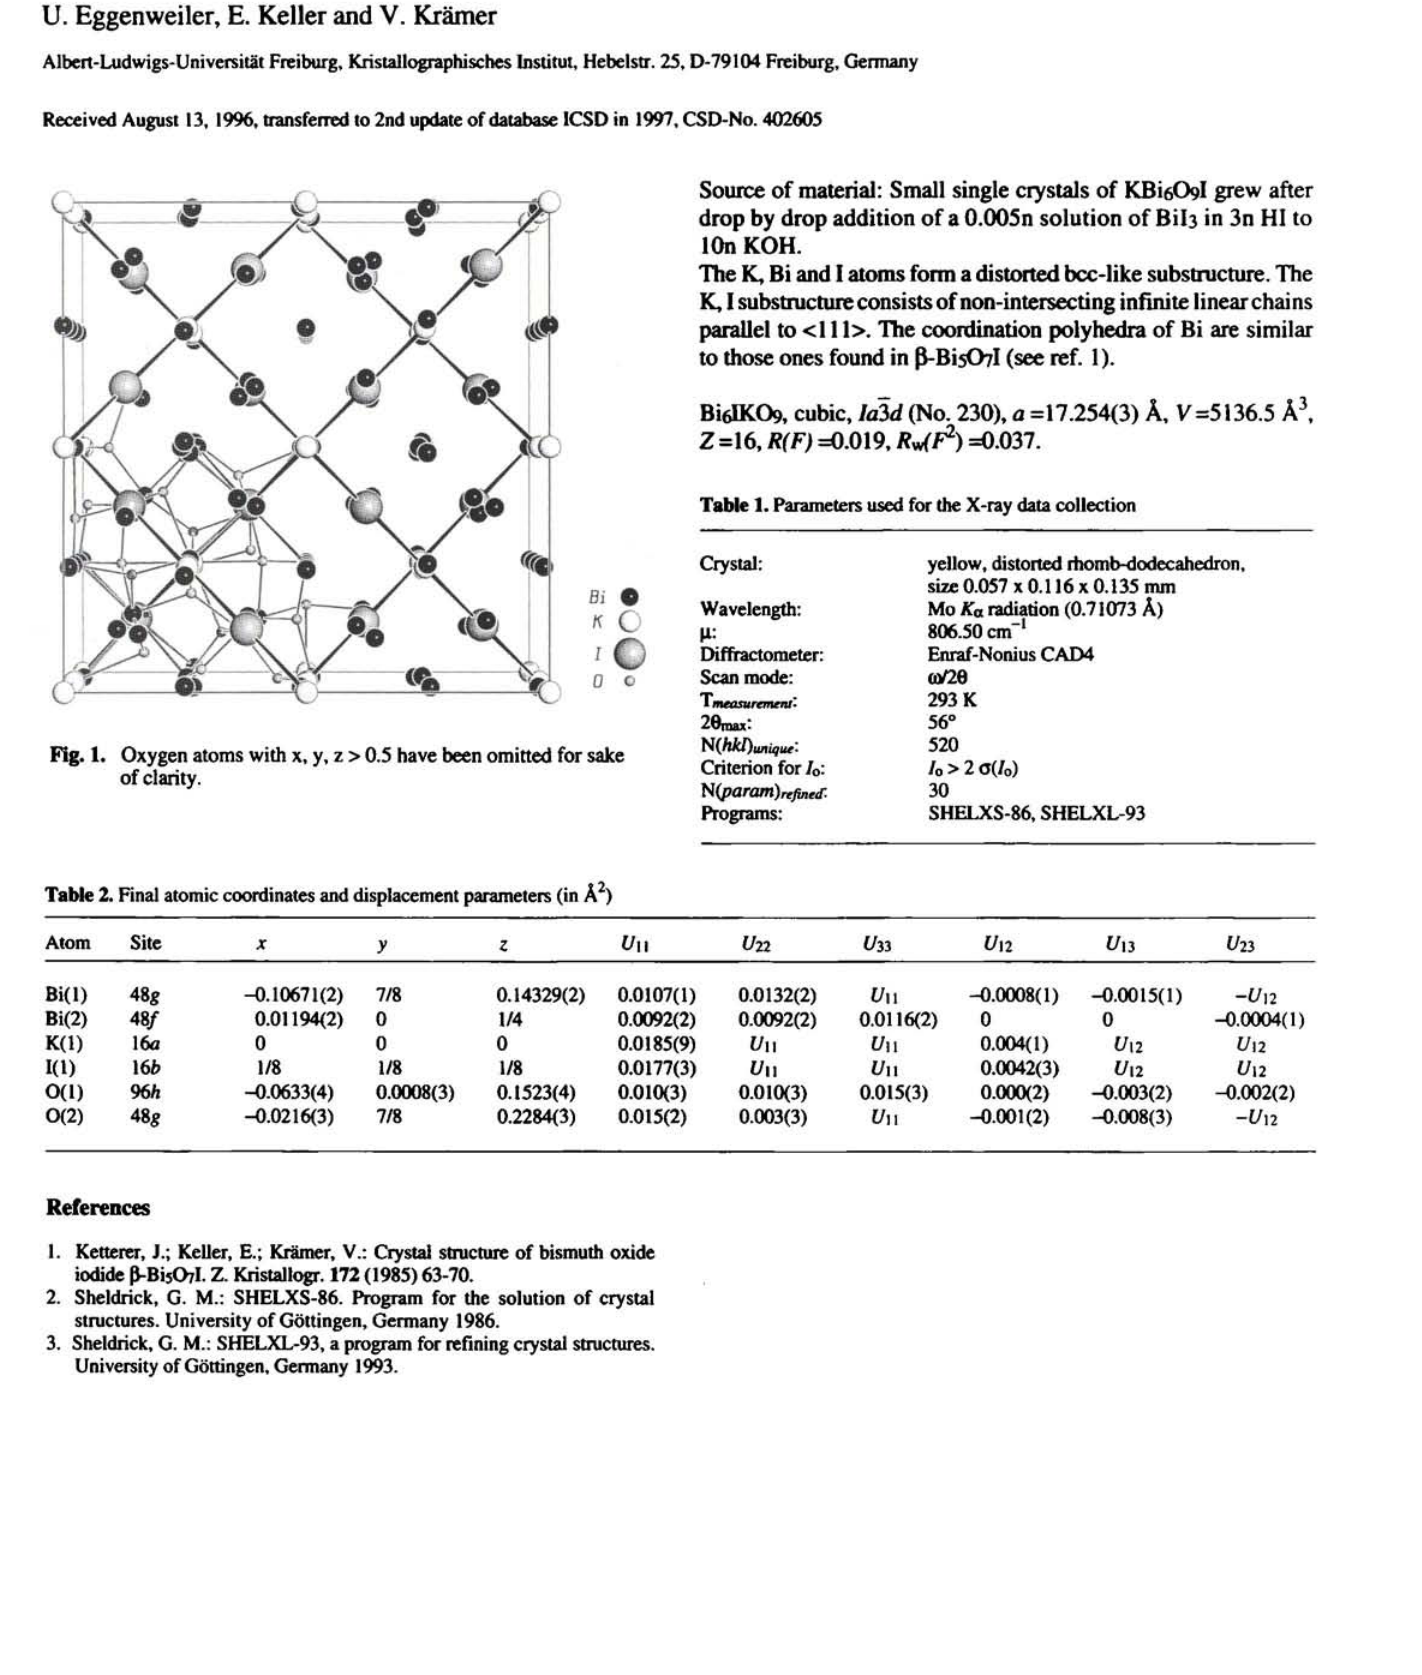
Table 1. Parameters used for the X-ray data collection Crystal: